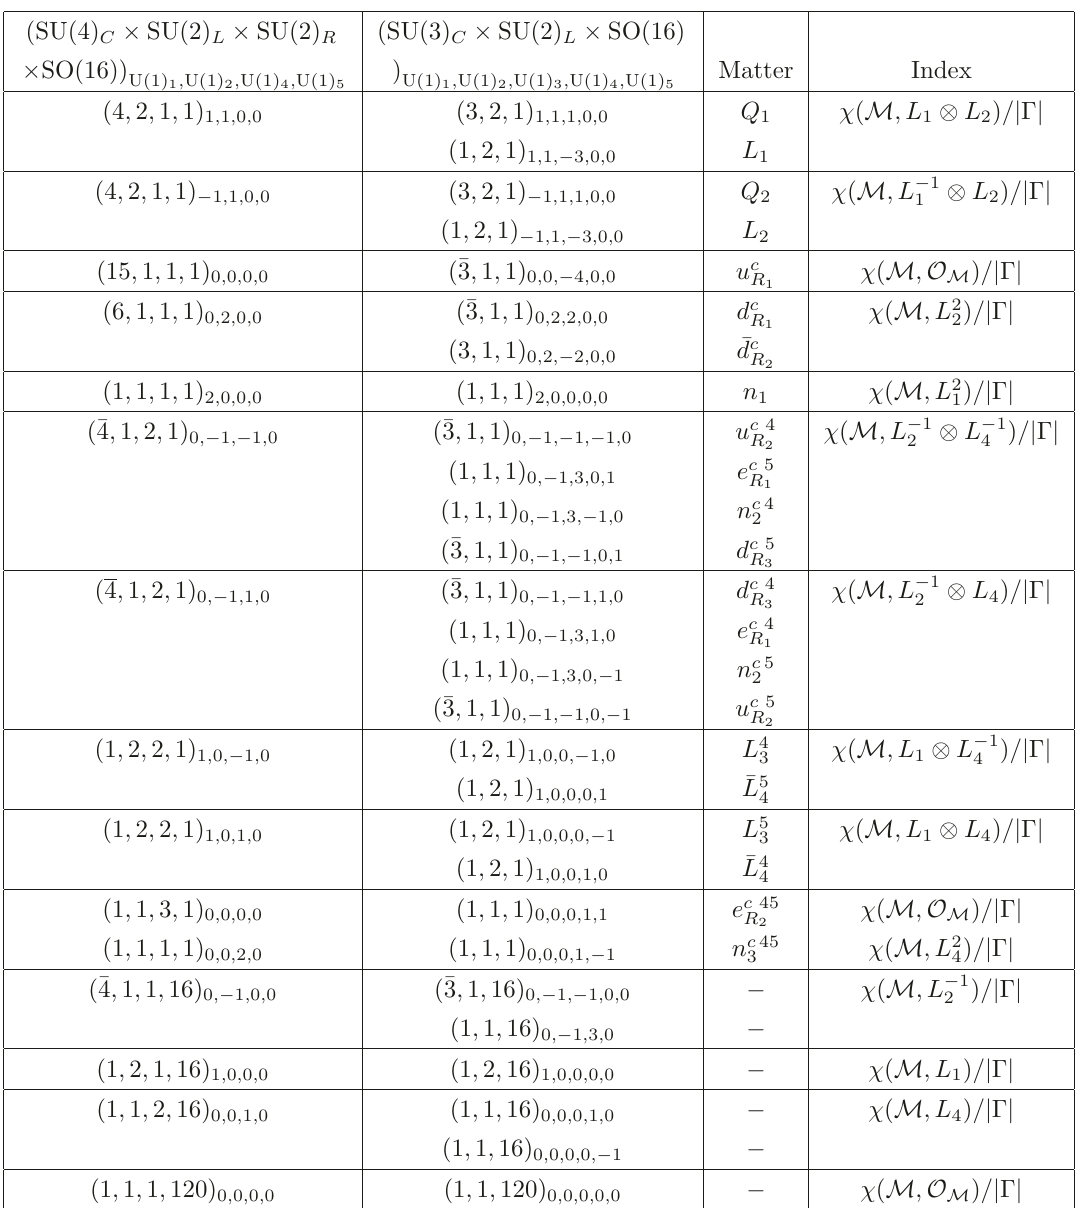
Table 3 . Massless spectrum and corresponding index. In the first and second columns, the en- tries refer to the representations under (SU(4) C SU(2) L SU(2) R SO(16)) U(1) 1 , U(1) 2 , U(1) 4 , U(1) 5 × × × and (SU(3) C SU(2) L SO(16)) and the subscript indices label the U(1) U(1) 1 , U(1) 2 , U(1) 3 , U(1) 4 , U(1) 5 × × , q ′ ) charges. Note that in the first column, two U(1) 4 , 5 charge vectors q = ( q 4 , q 5 ) and q ′ = ( q ′ 5 4